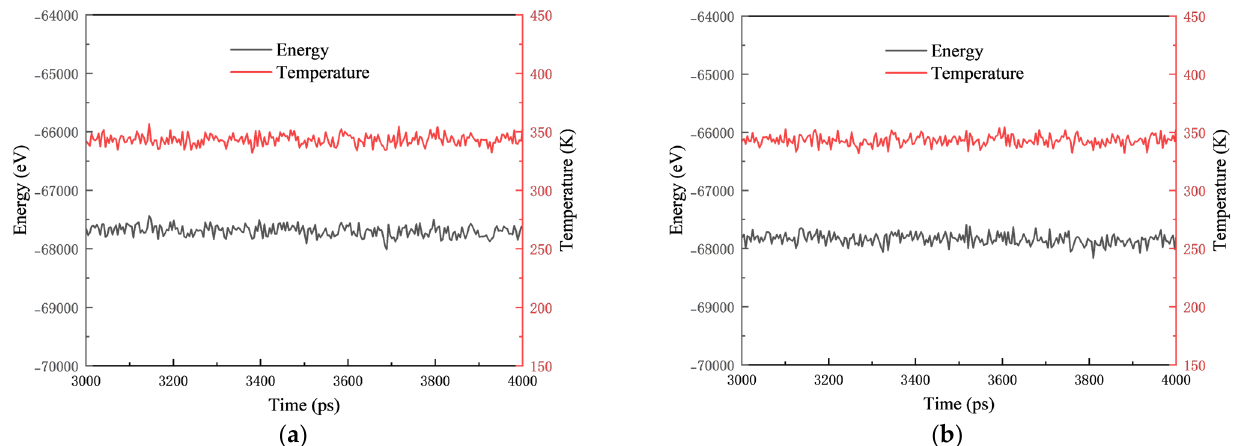
Figure 3. Evolution of system temperature and energy for ( a ) Fe plate and ( b ) PDA coating.